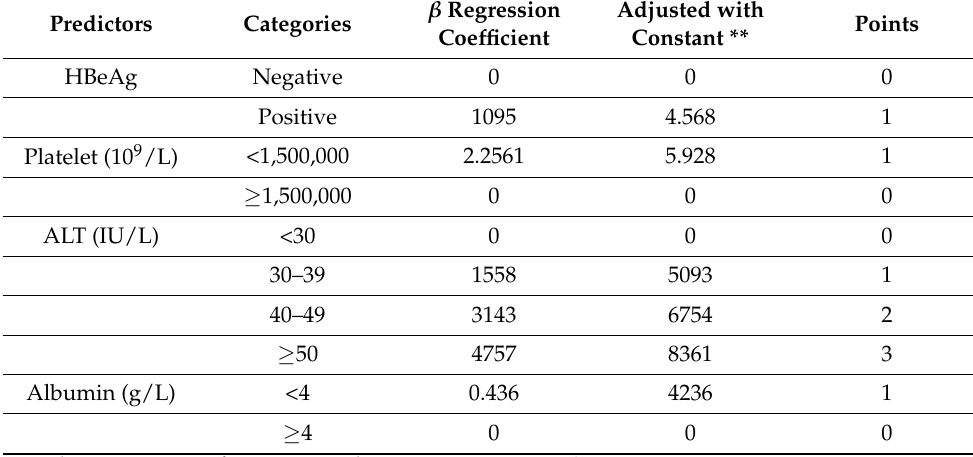
Table 3. Development of HePAA scoring system based on the logistic regression model. Predictors